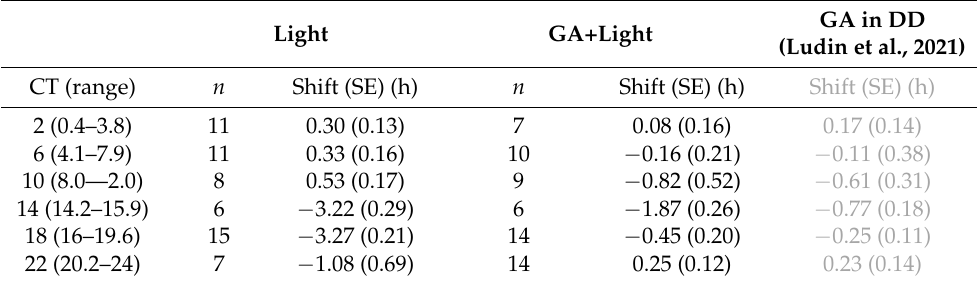
Figure 1. Phase response curves for the effects of four hours of isoflurane + light (black line) ( n = 60) and 4 h of light (red line) ( n = 58) on locomotor activity of C57/BL6 mice at different circadian times. Data are binned into four hour epochs. Error bars represent the standard error of the mean (SEM) of each epoch. Grey line at zero represents no phase shift. The PRC for 6 h of GA in DD is plotted in grey for comparison [9]. Table 1. Summary statistics of circadian times (CT) and phase shifts for behavioural phase shifting experiments with Light (400 lux, 4 h) and GA (2% isoflurane) + Light (400 lux). Shifts from GA in DD (2%, 6 h) are included in grey for the sake of